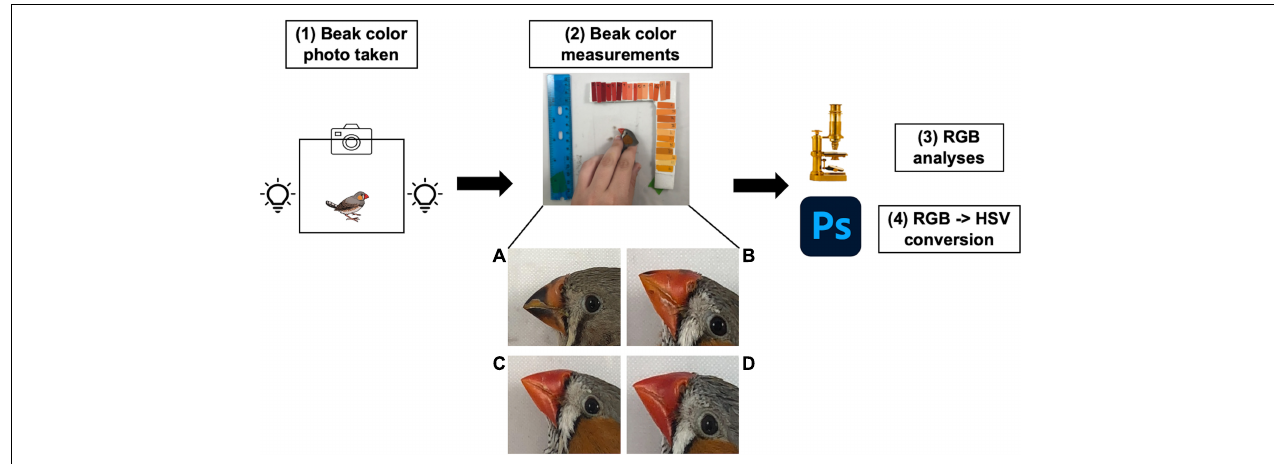
FIGURE 1 | Beak color measurement and RGB/HSV conversion protocols. (1) Beak photos were taken using a standardized photography arena, with lights placed on either side of the arena and a tripod calibrated to a set distance to hold the iPhone. (2) The bird was laid flat onto the surface of the photography arena, ensuring visibility of the beak. Beak color/carotenoid accumulation is visualized in panels (A–D) , which represents a male zebra finch at 45 (A) , 60 (B) , 75 (C) , and 95 (D) dph. (3) Beak photos were then quantified for red, green, and blue (RGB) measurements using ImageJ, (4) those RGB values were converted into hue, saturation, and value (HSV) correlates and those HSV measurements were cross-examined using Adobe